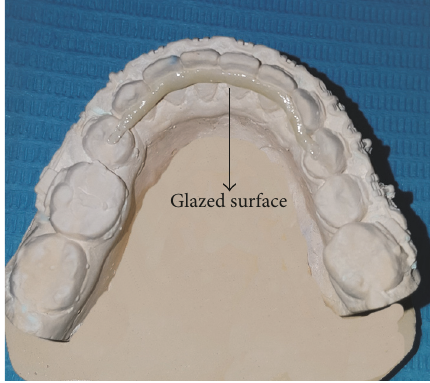
Figure 4: CAD/CAM zirconium bar fitted into the cast.